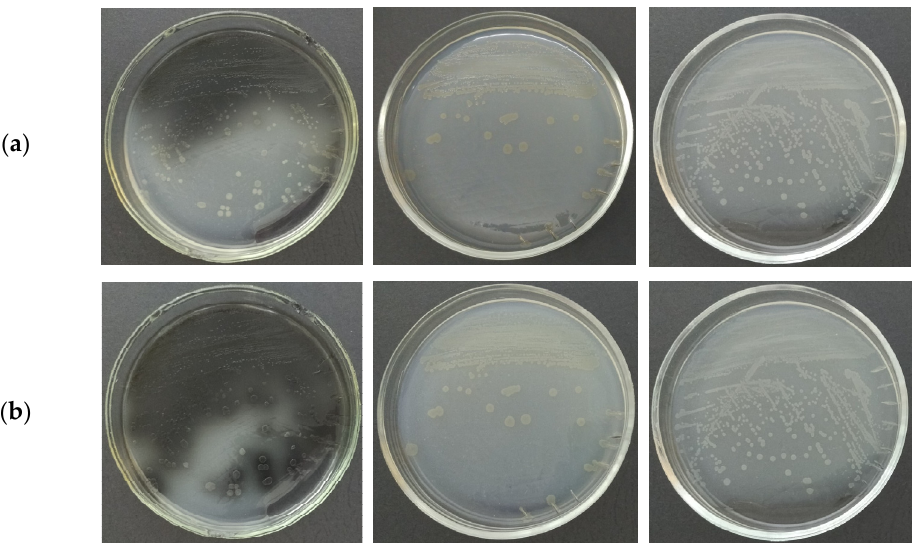
Figure 1. The strains P. distincta KMM 638 T (left, diffusible black pigmentation), P. distincta KMM 3548 (formerly P. paragorgicola KMM 3548) (middle, cell-bound slight yellow-orange pigmentation), and P. distincta KMM 701 (right, whitish) were cultivated on marine agar under the daylight for 7 ( a ) and 9 ( b ) days at 24 °C. Table 2. Fatty acid composition (%) of strains belonging to the species P. distincta and P. arctica